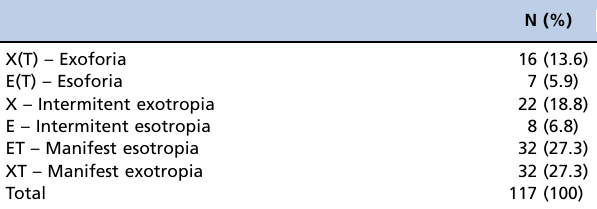
Table 2 - Distribution of Ocular Movement